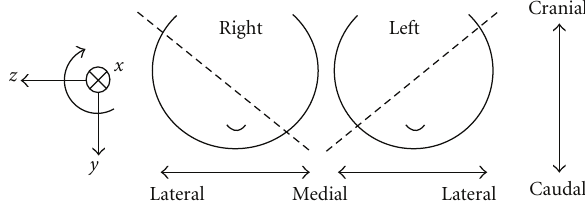
Figure 3: Anatomical directions and cartesian coordinate system. Dotted lines represent MLO image